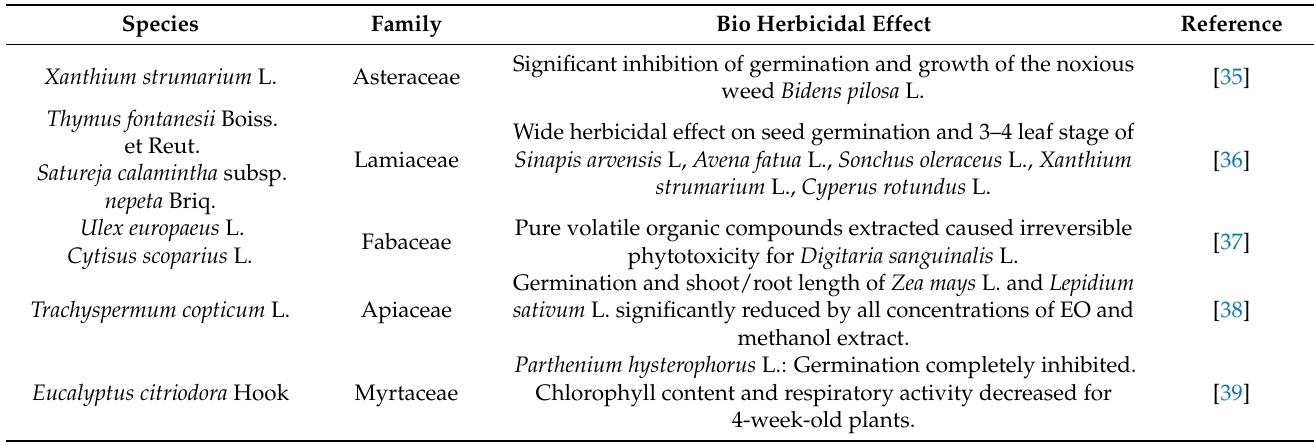
Table 2. Examples of frequently tested families for bioherbicidal